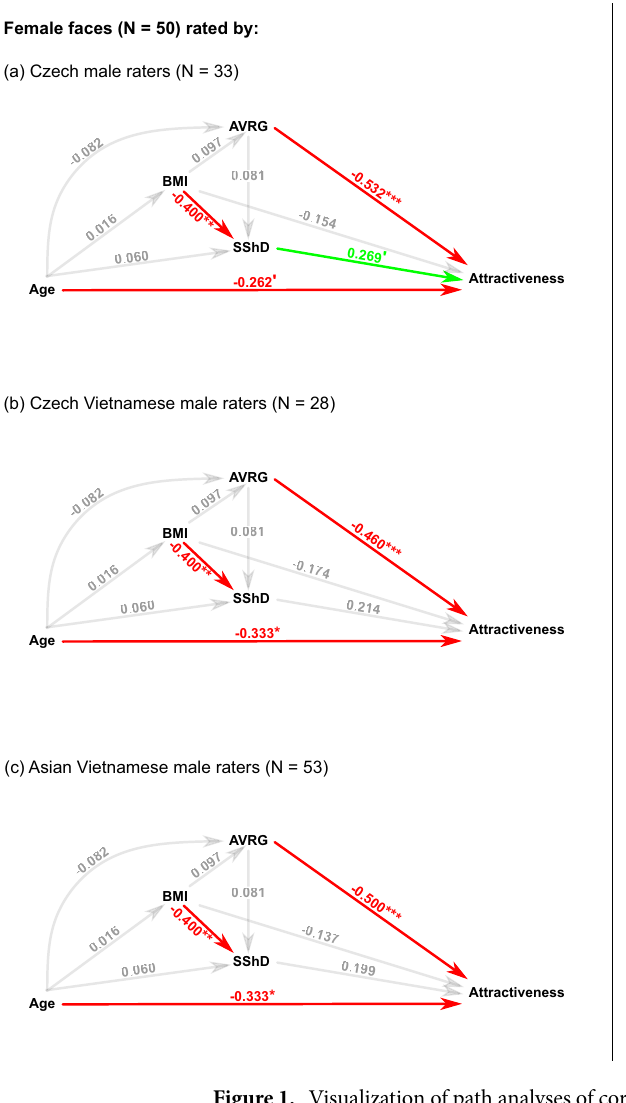
The dataset and R code is available at https ://osf.io/9a5mt /.